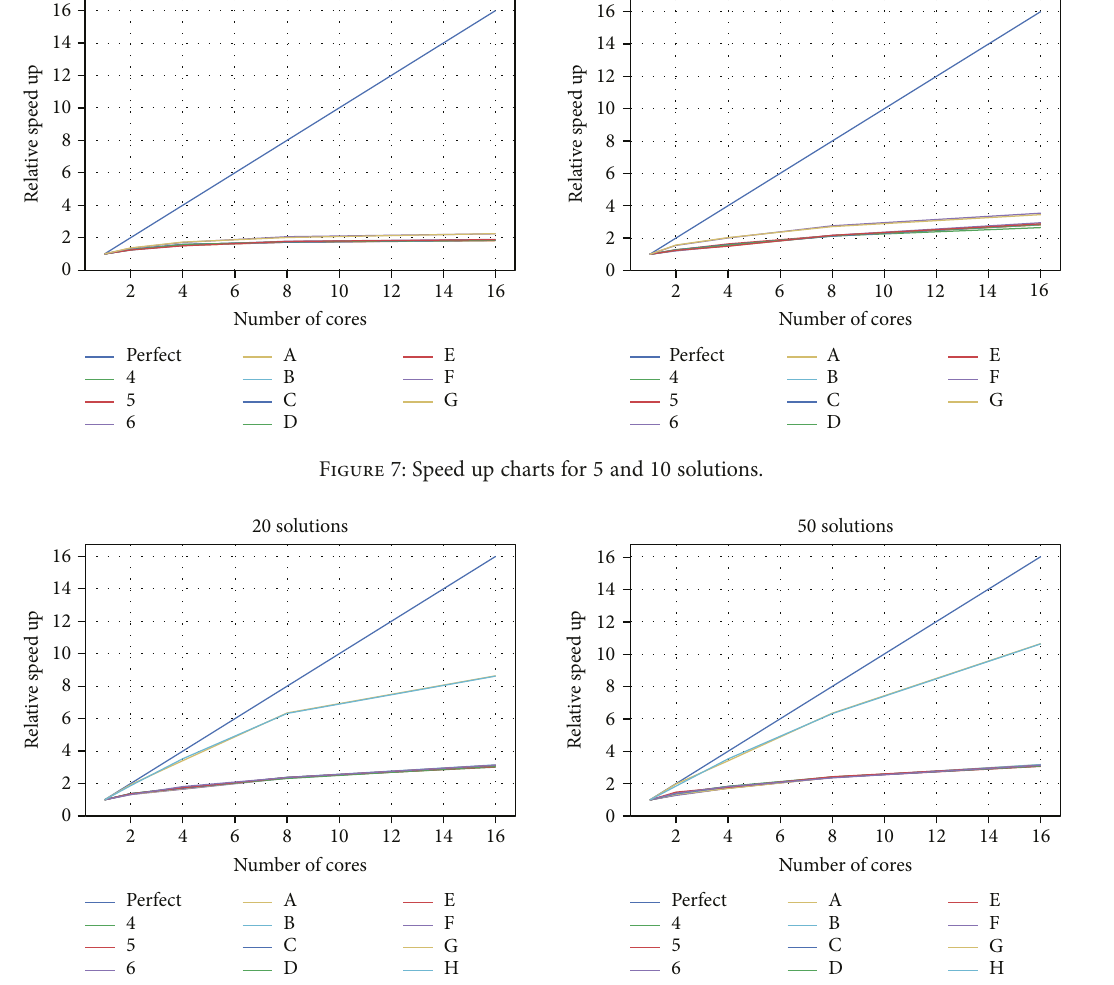
Figure 8: Speed up charts for 20 and 50 solutions.